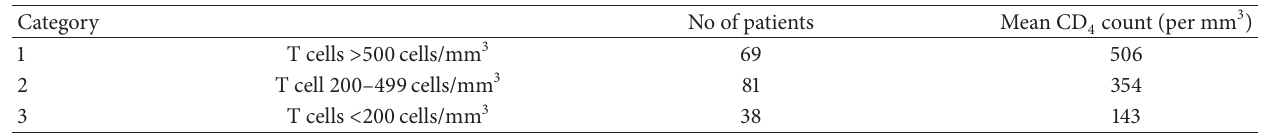
Table 4: The distribution of the Human Immunodeficiency Virus (HIV) infected in study participants as per Centers for Disease Control classification for HIV-infected adults and adolescents with the mean CD4 lymphocyte count in each category (WHO,